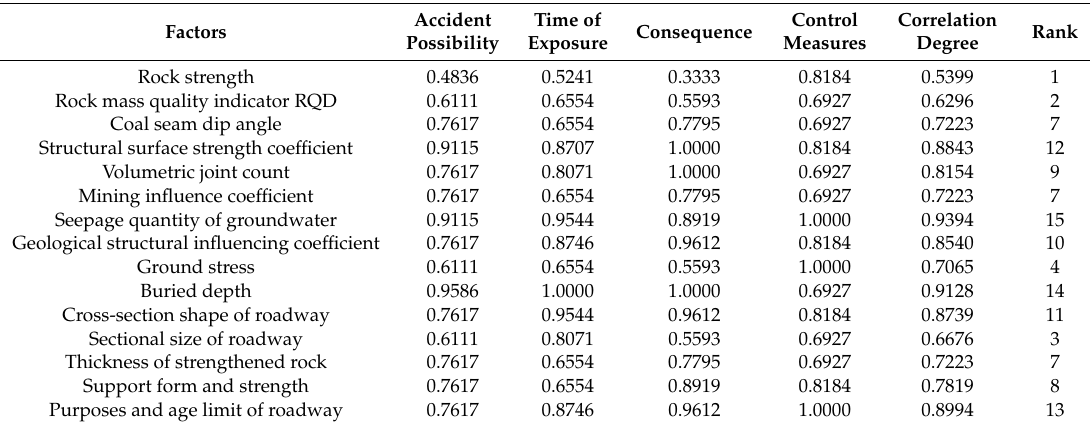
Table 6. Correlation coe ffi cient and sorting of correlation degree.